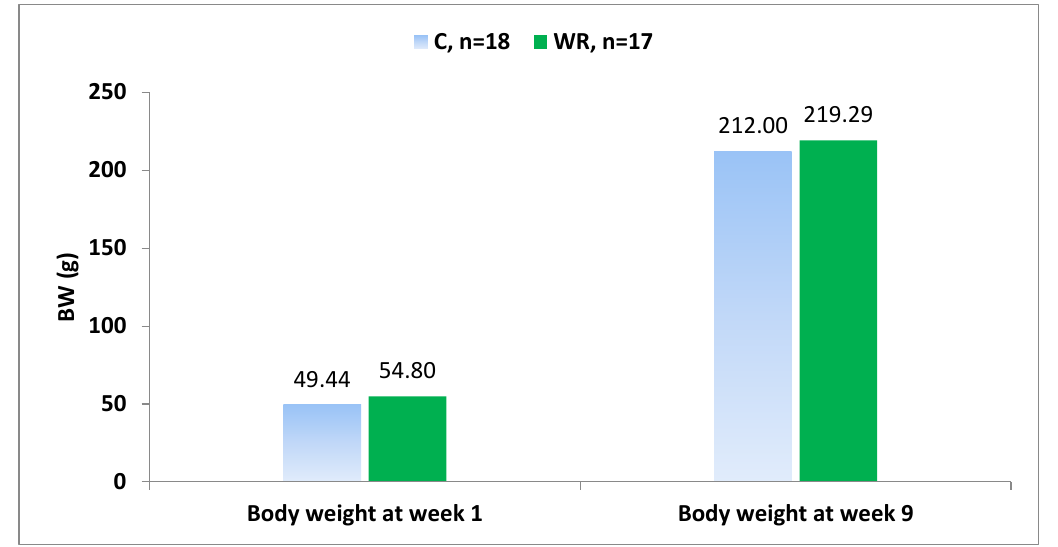
Figure 3. Body weight of male offspring (F1) post weaning in control and water-restricted group. SE: Standard error of the mean. Differences ( p < 0.05) were not detected. Table 2. Pregnancy outcomes and characteristics of F1 in control and water-restricted group.